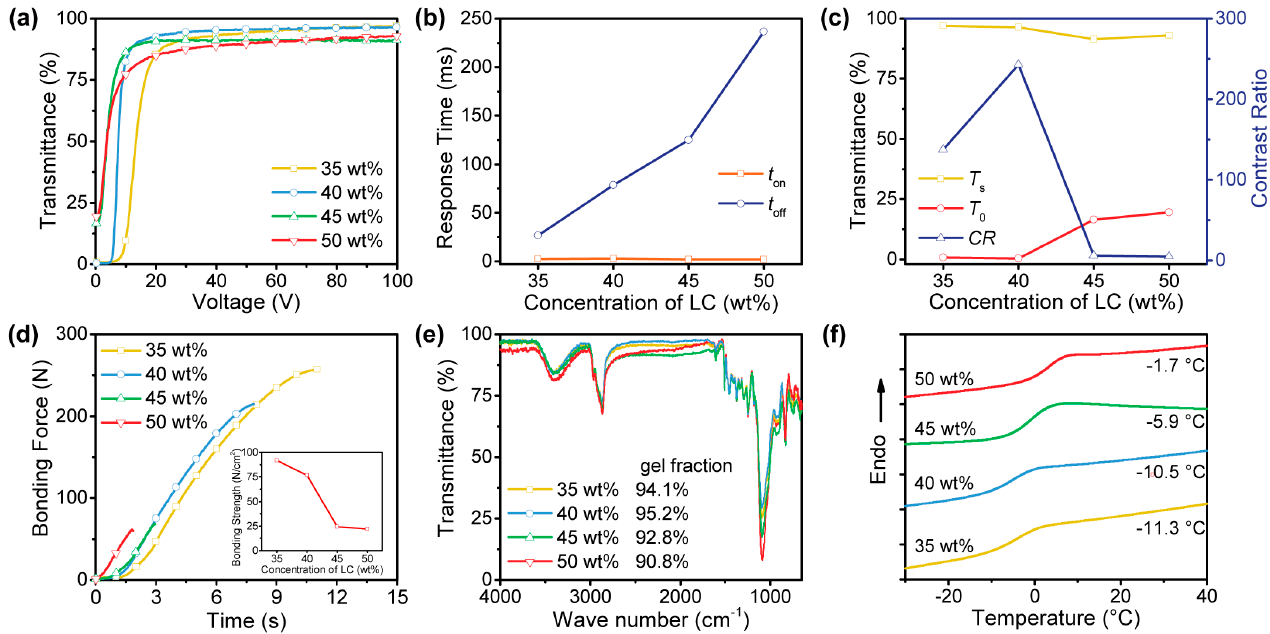
Figure 2. ( a ) The voltage dependence of the transmittance, ( b ) the response time, ( c ) the saturation transmittance, off-state transmittance, contrast ratios, and ( d ) adhesion strength of samples A1–A4; ( e ) FTIR spectra and gel fractions and ( f ) DSC thermographs of the polymer matrix of samples A1–A4.